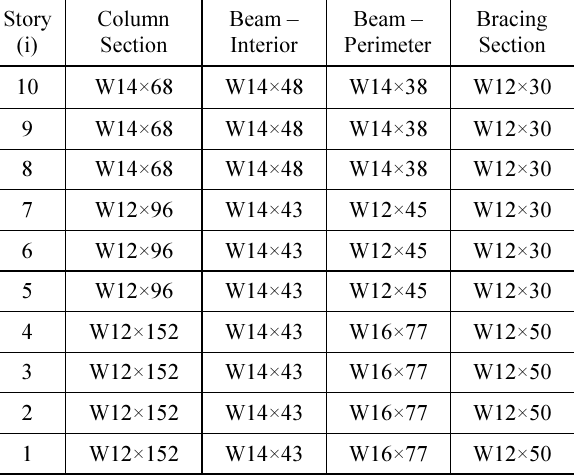
Table 4. Material properties (1 ksi = 6.9